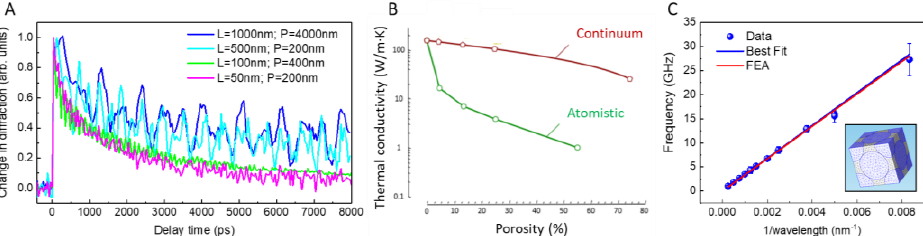
Fig. 2. Thermal transport and acoustic dynamics of a 30nm Si metalattice A) Change in diffraction as a function of pump-probe delay for gratings with linewidths of 1000-50nm. B) Equilibrium Green – Kubo atomistic simulations of Si metalattices. The thermal conductivity is highly reduced as the porosity increases compared to continuum mechanics. C) From the SAWs launched, we extract a dispersion relation which is in excellent agreement with theory. Inset shows the simulated